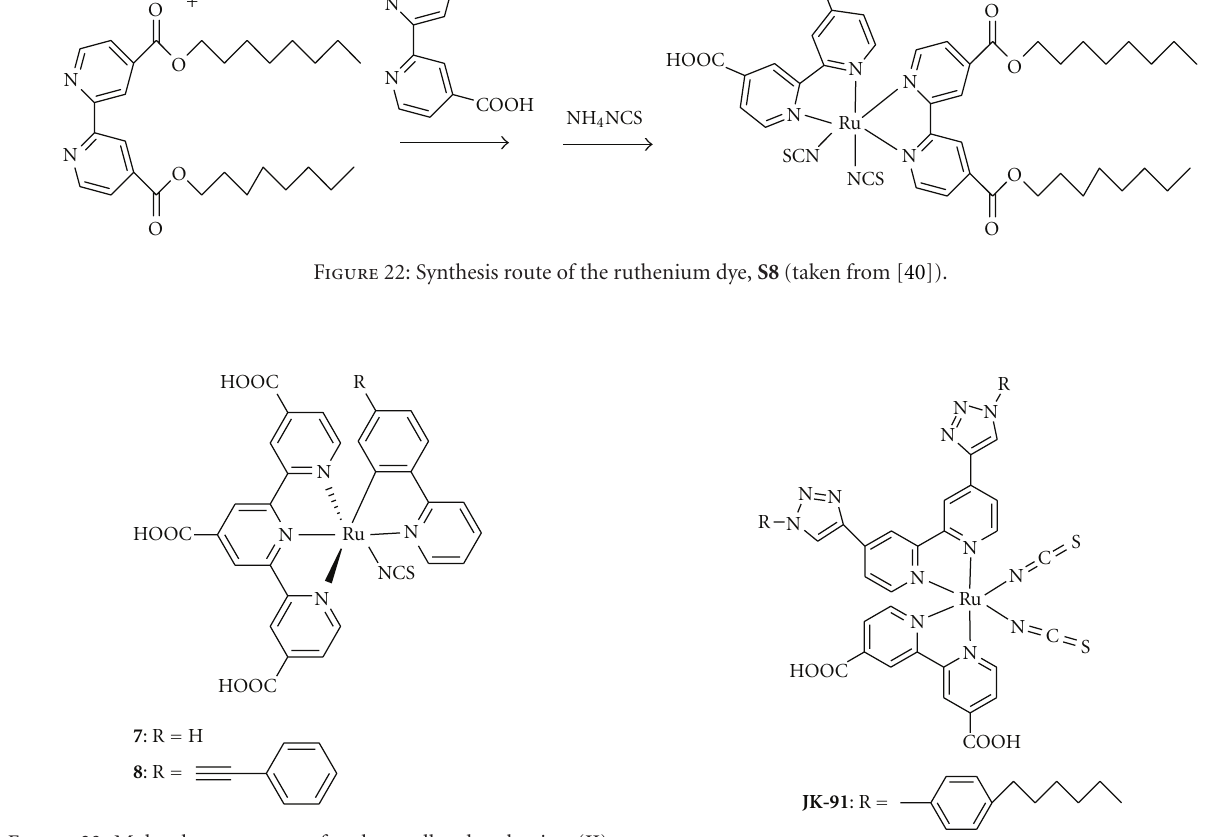
Figure 23: Molecular structures of cyclometallated ruthenium(II) complexes (taken from [41]).